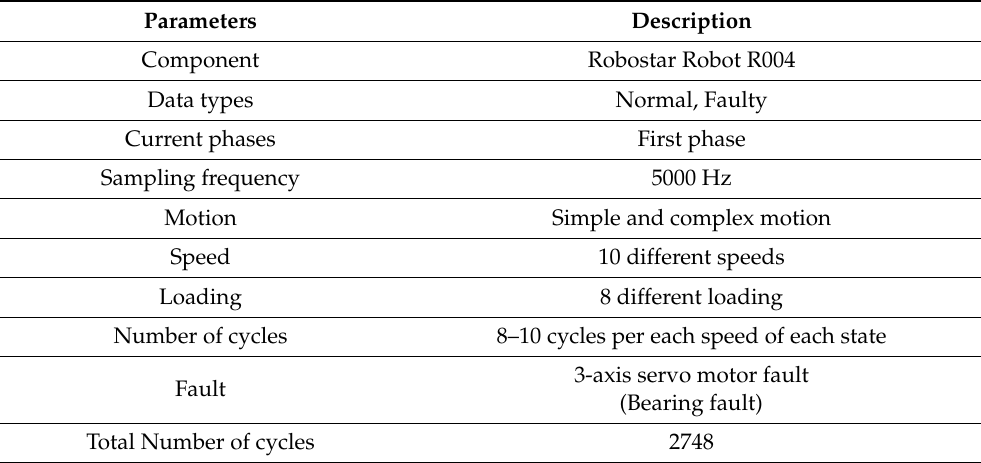
Table 2. Detailed information about the collected